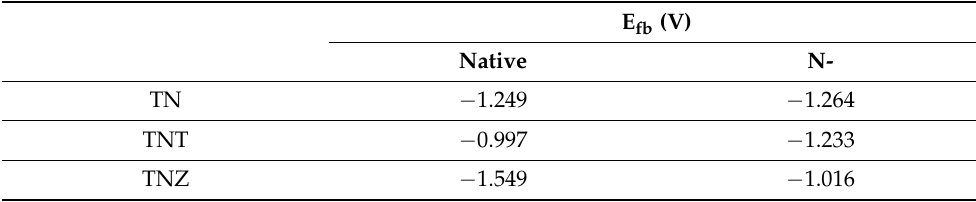
Figure 4. Mott–Schottky plots of alloys in physiological solution. Table 5. Flat-band potential determined from Mott–Schottky